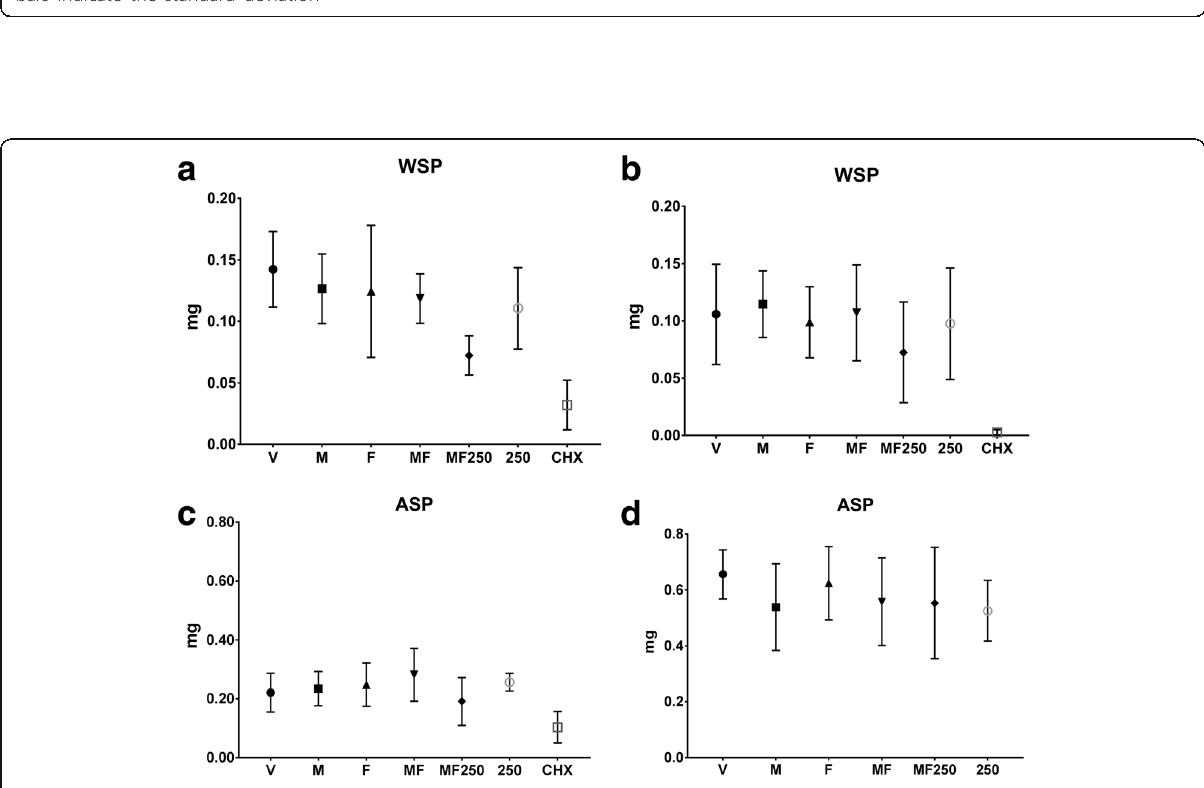
Fig. 5 Exopolysaccharides quantities in the ECM after treatments. Both water soluble (WSP) and water insoluble (ASP) exopolysaccharides in the extracellular matrix are represented in milligrams (mg). ( a ) and ( c ) represent data generated for regimen one, while ( b ) and ( d ) correspond to regimen two. Panels a and b depict WSP data and panels c and d show ASP data. V: vehicle; F: tt- farnesol; M: myricetin; MF: tt -farnesol + myricetin; MF250: fluoride + tt- farnesol + myricetin; 250: fluoride (250 ppm); CHX: chlorhexidine. The data shown are averages, and error bars indicate the standard